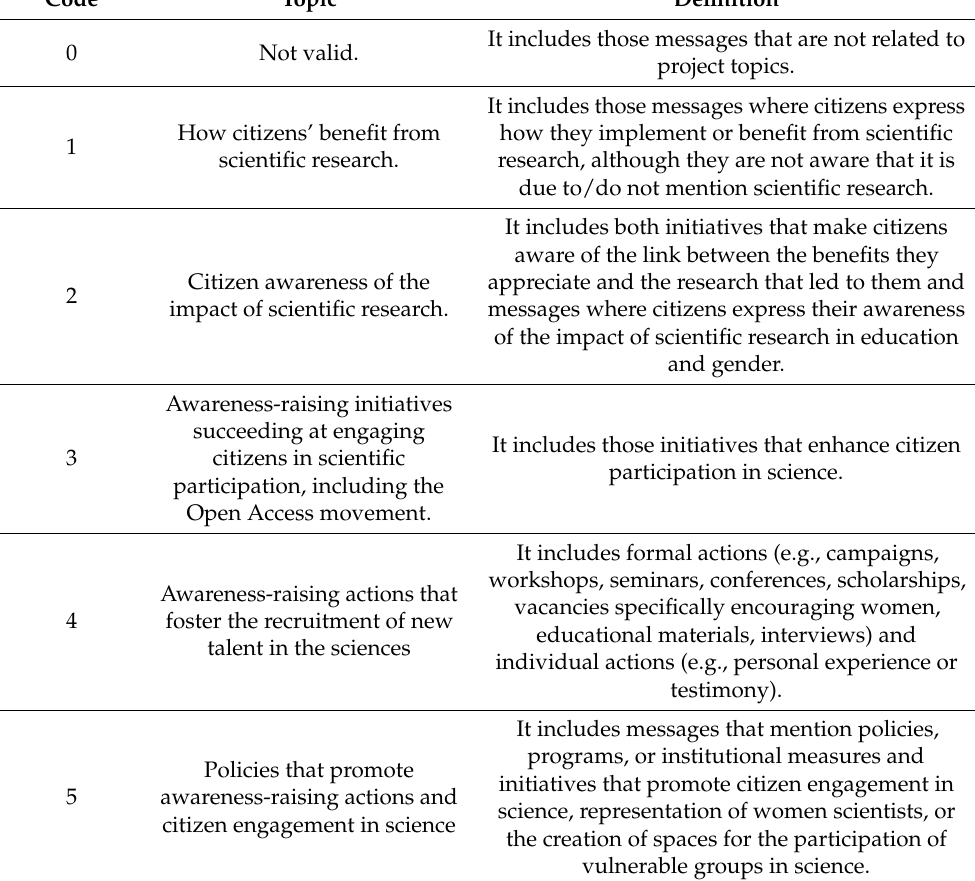
Table 1. Categories of analysis by topic. Code